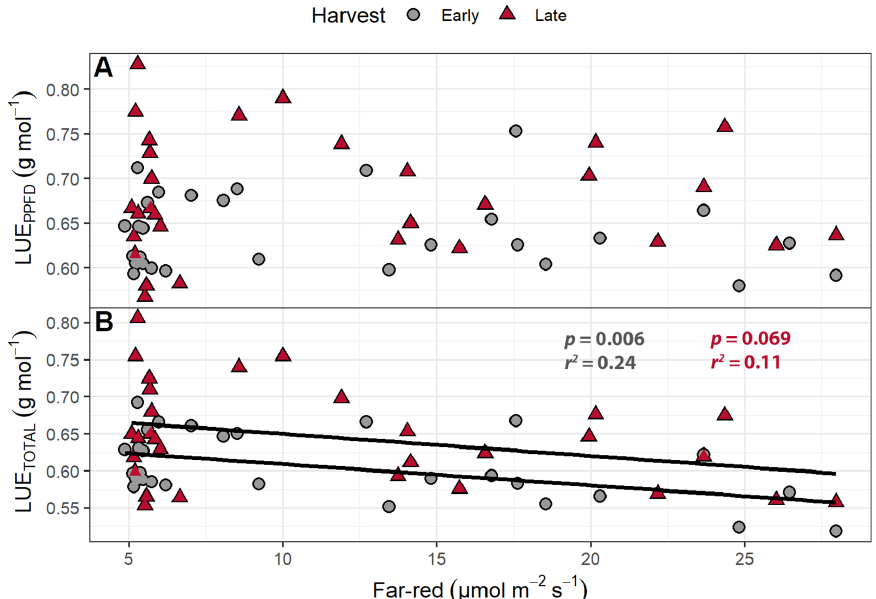
Figure 5. ( A ) The effect of supplemental far-red light on light use efficiency calculated based on photosynthetic photon flux density (LUE PPFD ) and ( B ) total photon flux density (LUE TOTAL ). The LUE PPFD and LUE TOTAL were calculated by dividing the shoot dry weight by the cumulative incident photosynthetic photon flux density (PPFD; 400–700 nm) or the incident total photon flux (400–800 nm), respectively, to determine how efficiently plants used incident light to produce biomass. “Green Salad Bowl” lettuce ( Lactuca sativa ) were grown under a PPFD of 207 ± 13 µmol m − 2 s − 1 supplemented with varying amounts of far-red. The early harvest occurred 16 days after germination, while the late harvest occurred 25 days after germination.